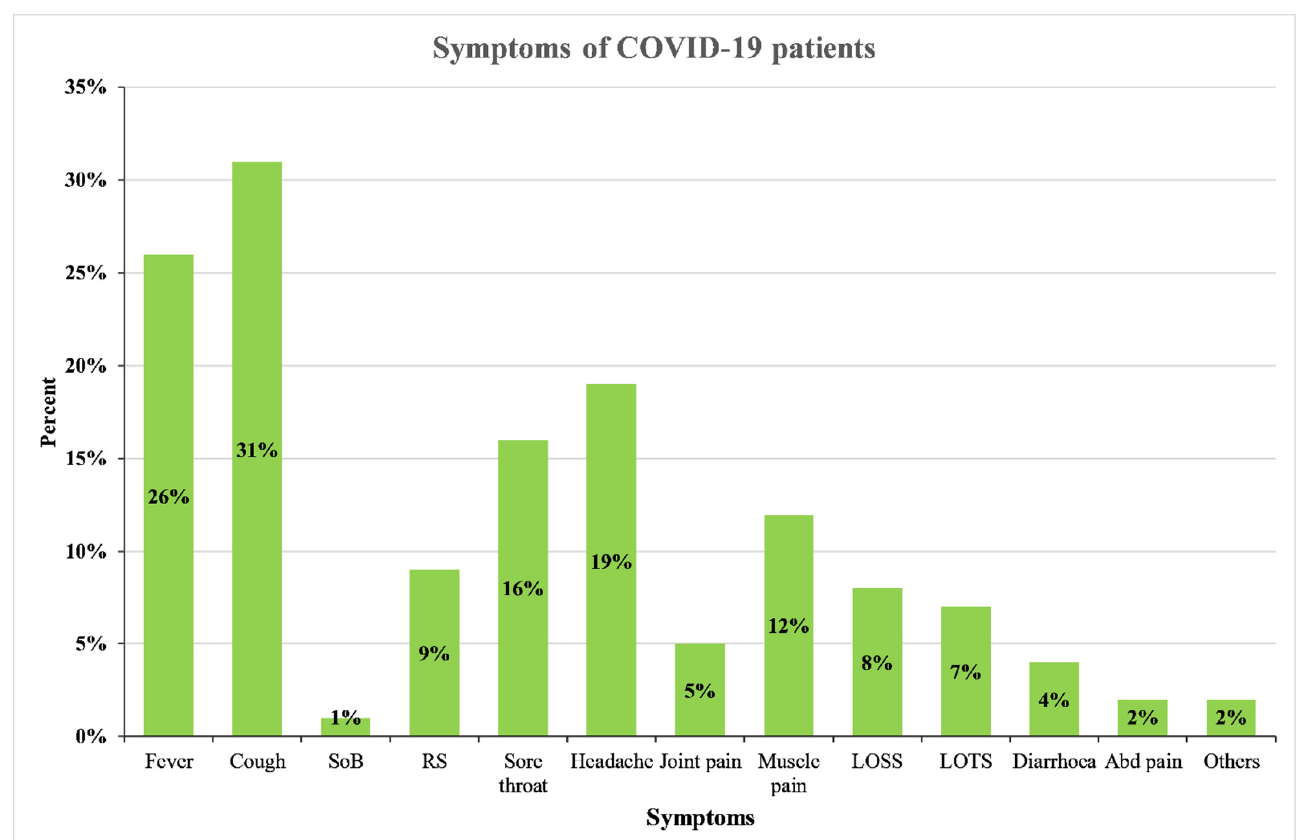
Figure 3. The proportion of different symptoms manifestations among COVID-19 patients. SOB- shortness of breath; RS- runny nose; LOSS- loss of smell sensation; LOTS- loss of taste sensation; Abd pain- abdominal pain; Others—chest pain, nausea, skin rashes. The mean white cell count on admission was 6.52 ± 2.149 × 10 3 per microliter; the mean absolute lymphocyte count was 1.88 ± 7540 × 10 3 per microliter; and the mean plate-